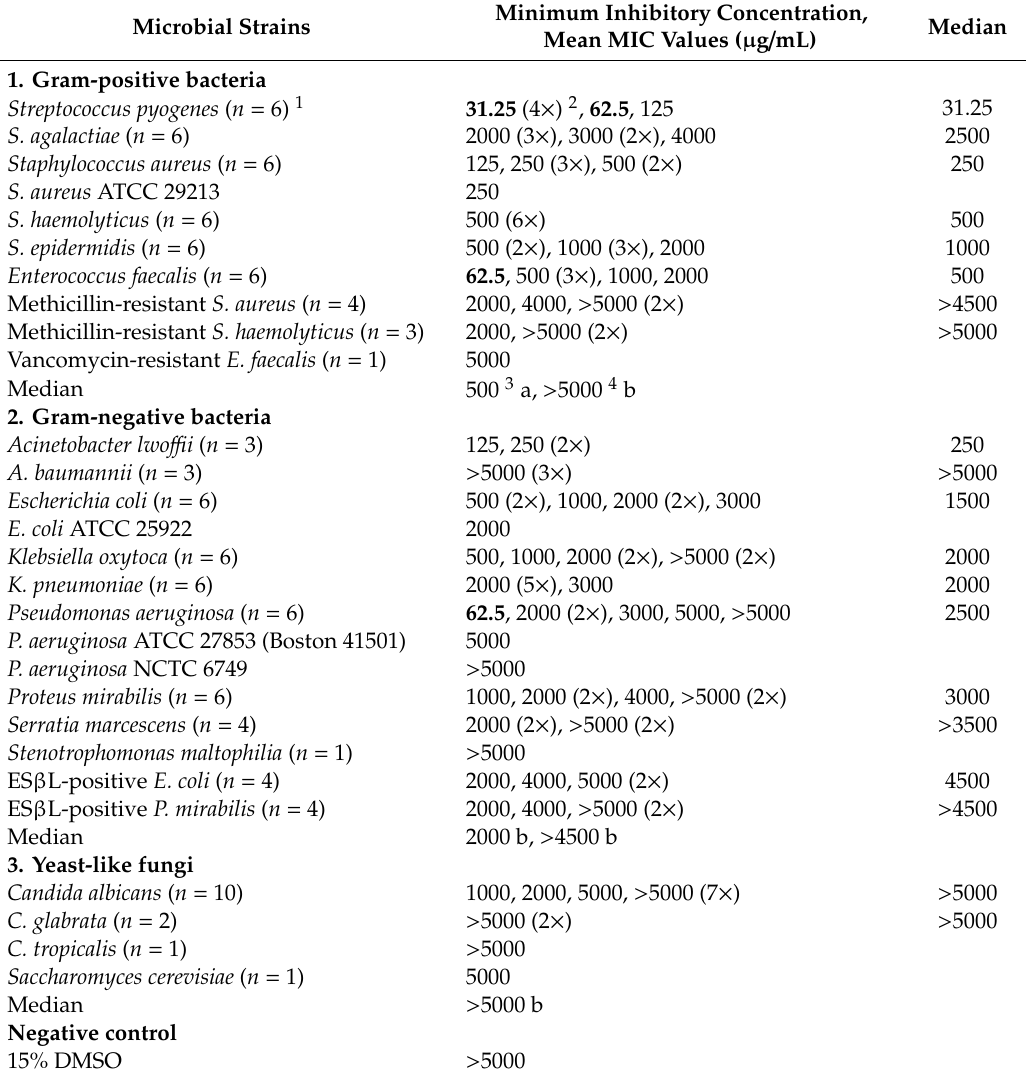
Table 1. Antimicrobial activity of curcumin against clinical and reference strains of